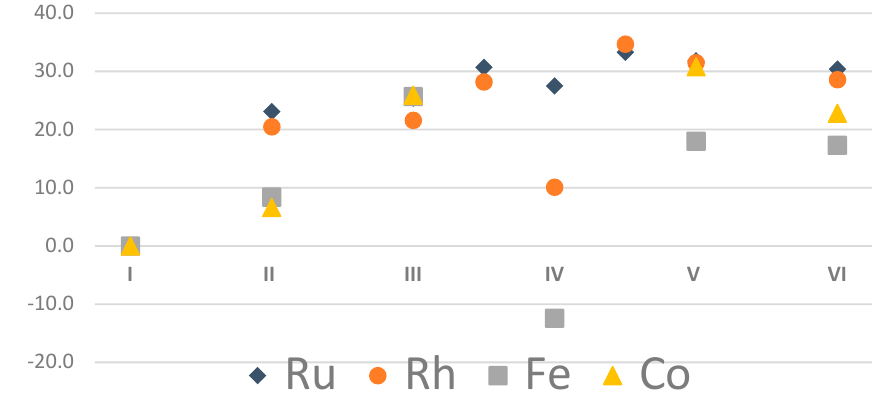
Figure 1. Reaction pathway (BP86-D3BJ/TZVP~sdd//BP86-D3BJ/TZVP~sdd Gibbs free energies in solvent in kcal/mol) for the olefin metathesis reaction pathway for M(SIMes)Cl 2 (=CHPh)PPh 3 (M = Ru and Rh) with ethylene as substrate.